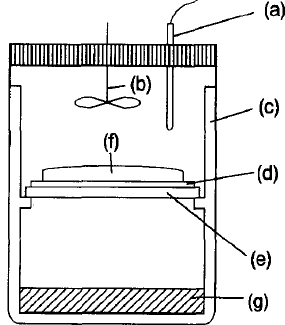
Figure 1. Schematic diagram of special autoclave for the vapor-phase transport synthesis: ( a ) thermocouple, ( b ) agitator, ( c ) Teflon vessel, ( d ) support, ( e ) perforated plate, ( f ) amorphous gel and ( g ) liquid phase. Reprinted with permission from ref. [28]. Copyright 1996, Elsevier.